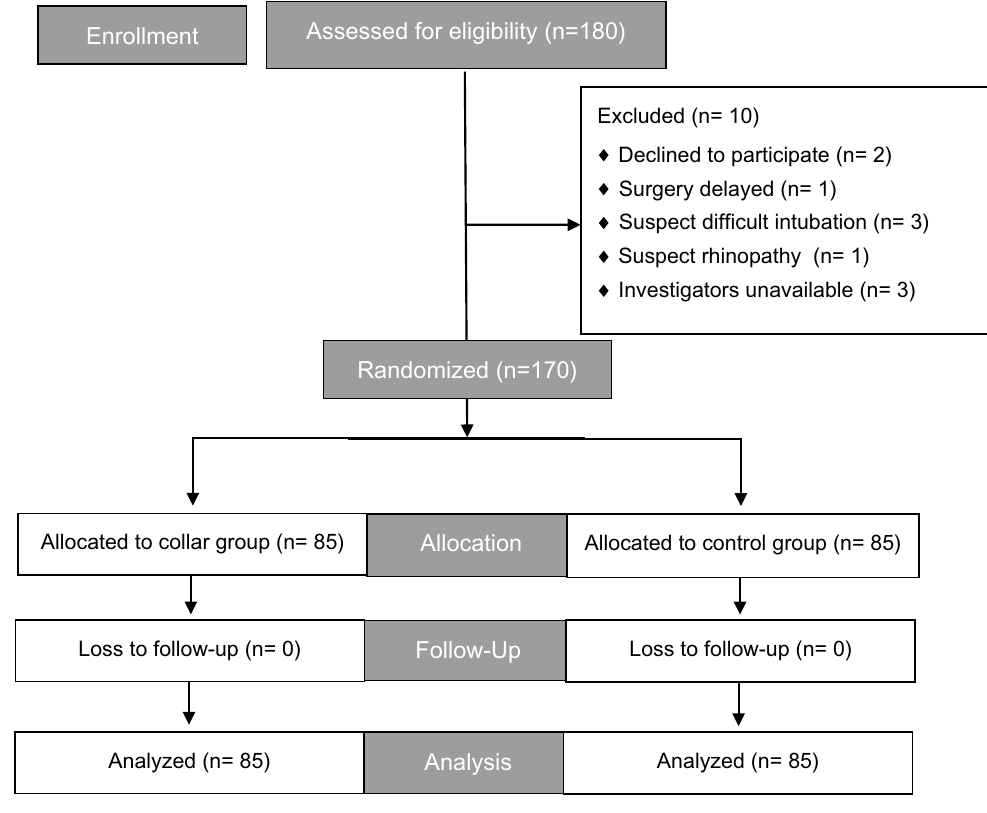
Figure 1. Consort diagram describing patient